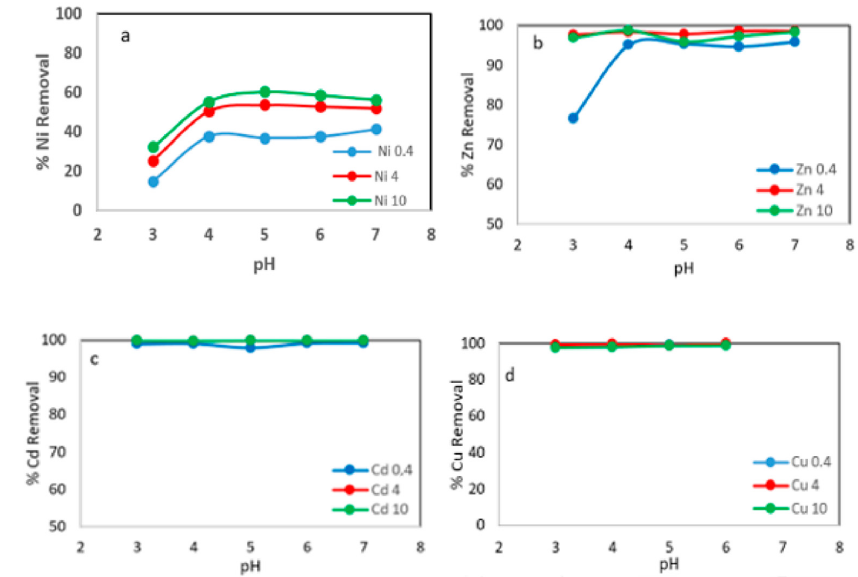
Figure 4. Metals removal onto WS versus initial pH at different adsorbent concentration: 0.4 g L − 1 , 4 g L − 1 and 10 g L − 1 . ( a ) % Ni removal; ( b ) % Zn removal; ( c ) % Cd removal; ( d ) % Cu removal.